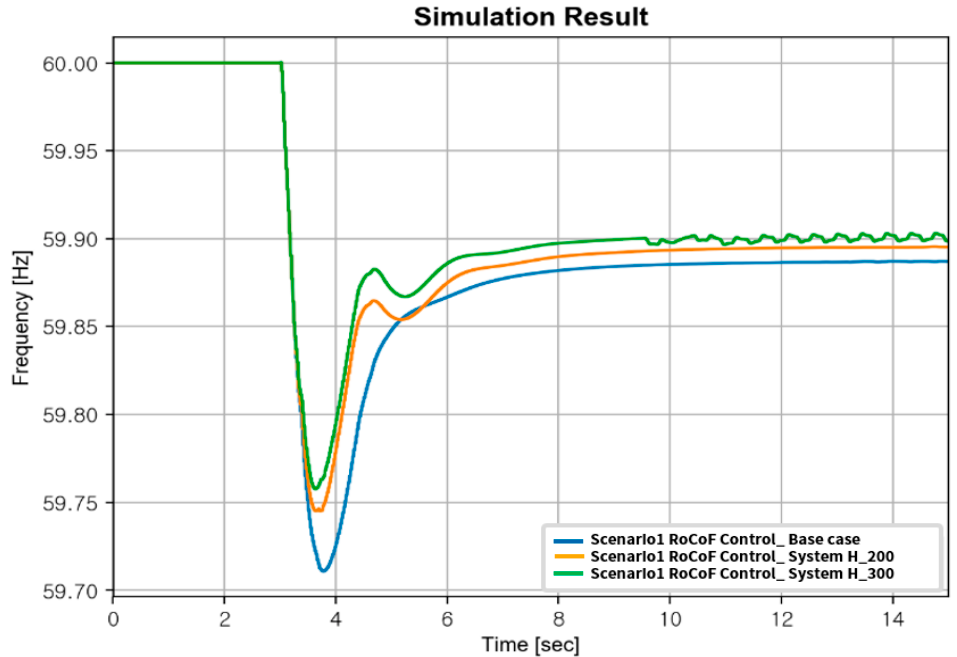
Figure A3. Frequency response by ESS parameter (system H (ESS output) for trans-state).